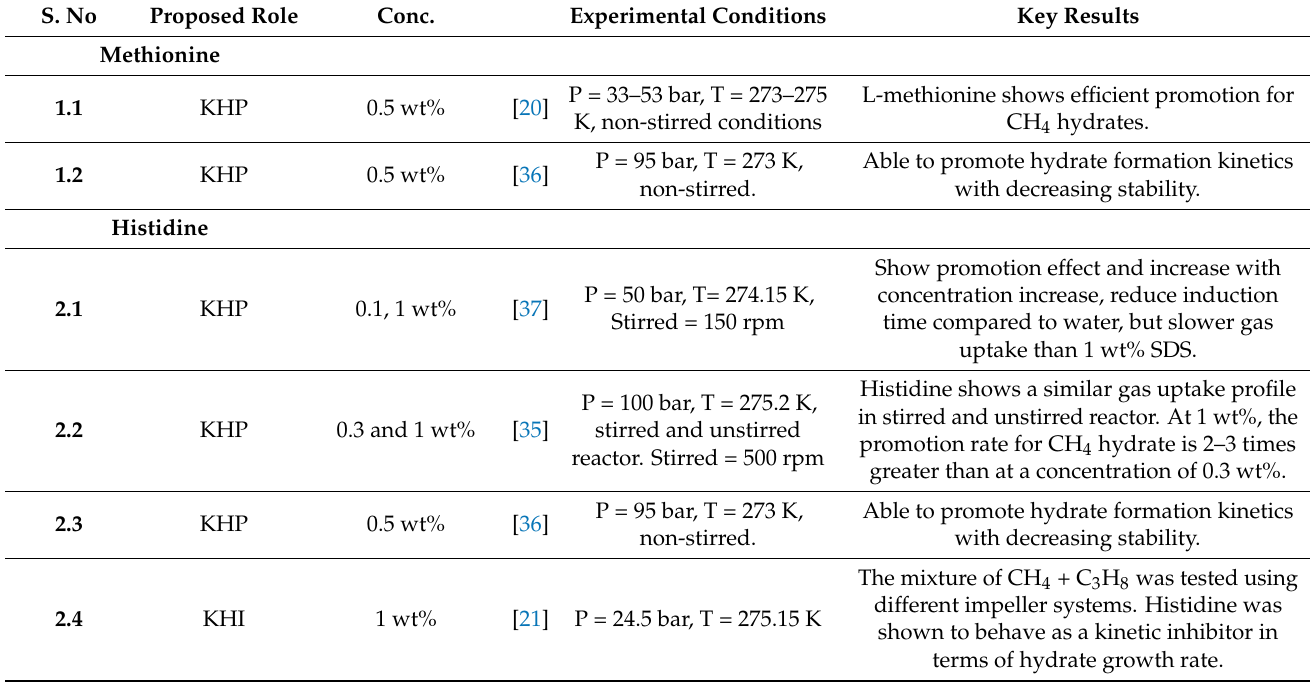
Table A11. Summary of similar studies carried out with L-methionine and L-histidine for CH 4 gas hydrates. S. No Proposed Role